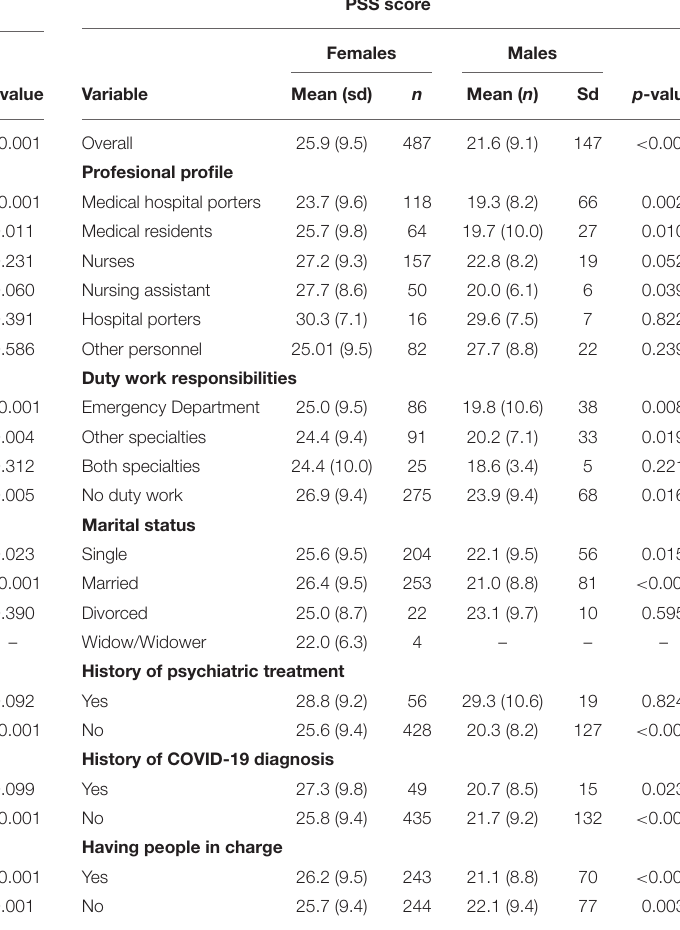
TABLE 2 | General Health Questionnary-28 results. TABLE 3 | Perceived Stress Scale